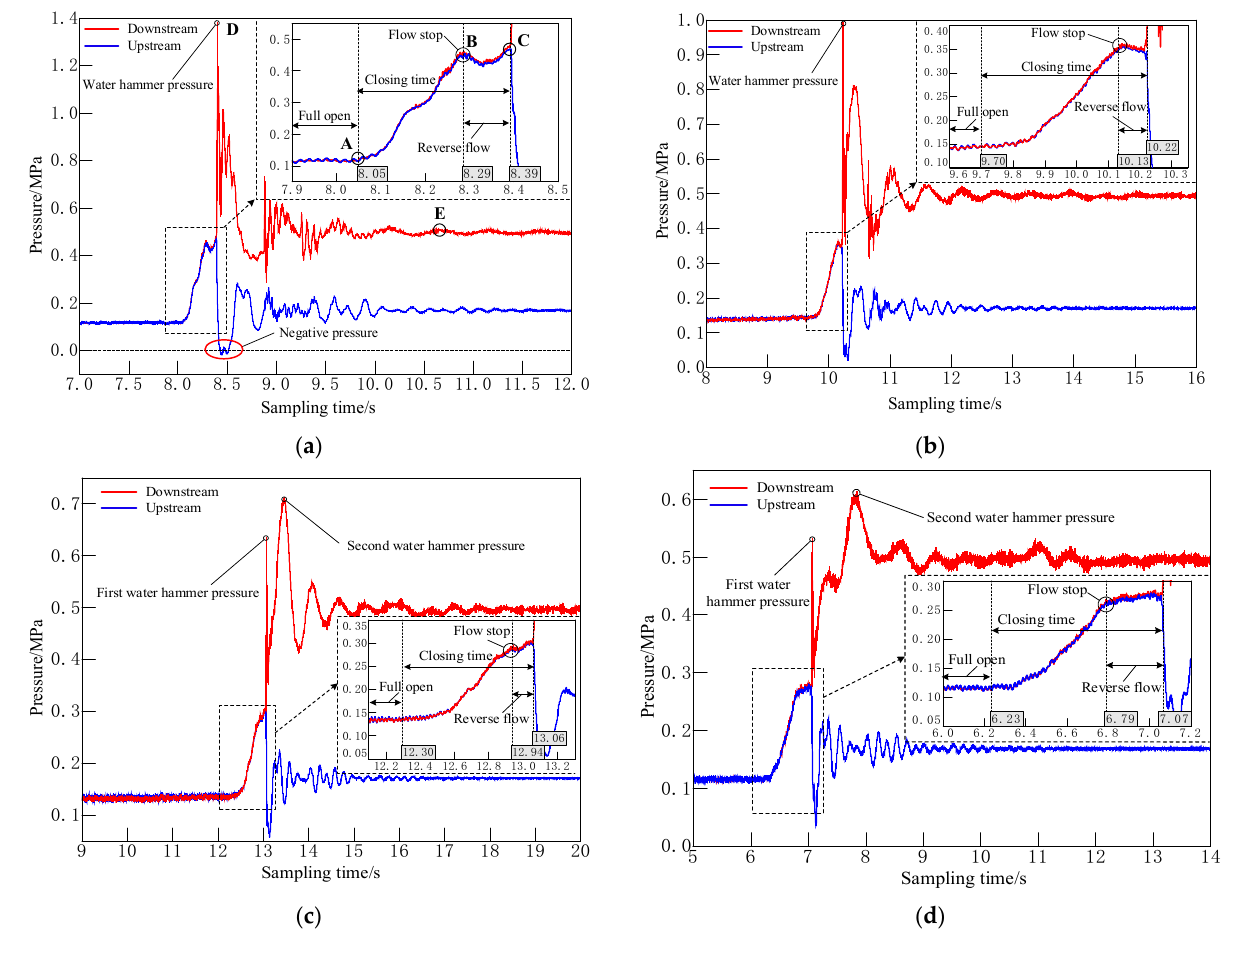
ginning to occur at point C, reaches the pressure peak of the water hammer at point D, then gradually subsides and stabilizes at point E [21,22].